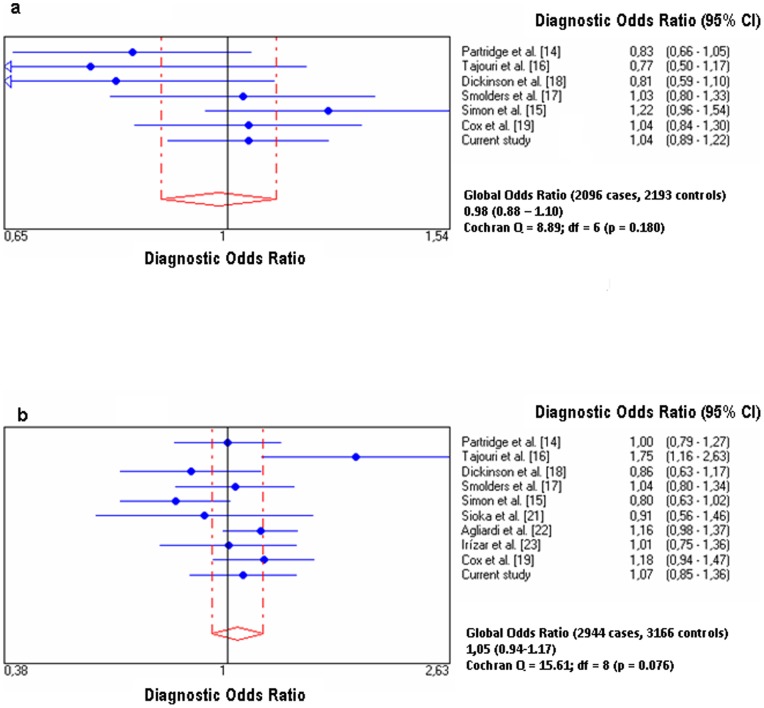
Diagnostic odds ratios and 95% confidence intervals (CI) for each study and for pooled samples of (1–a) rs2228570 (Fok1) and (1–b) rs731236 (Taq1).